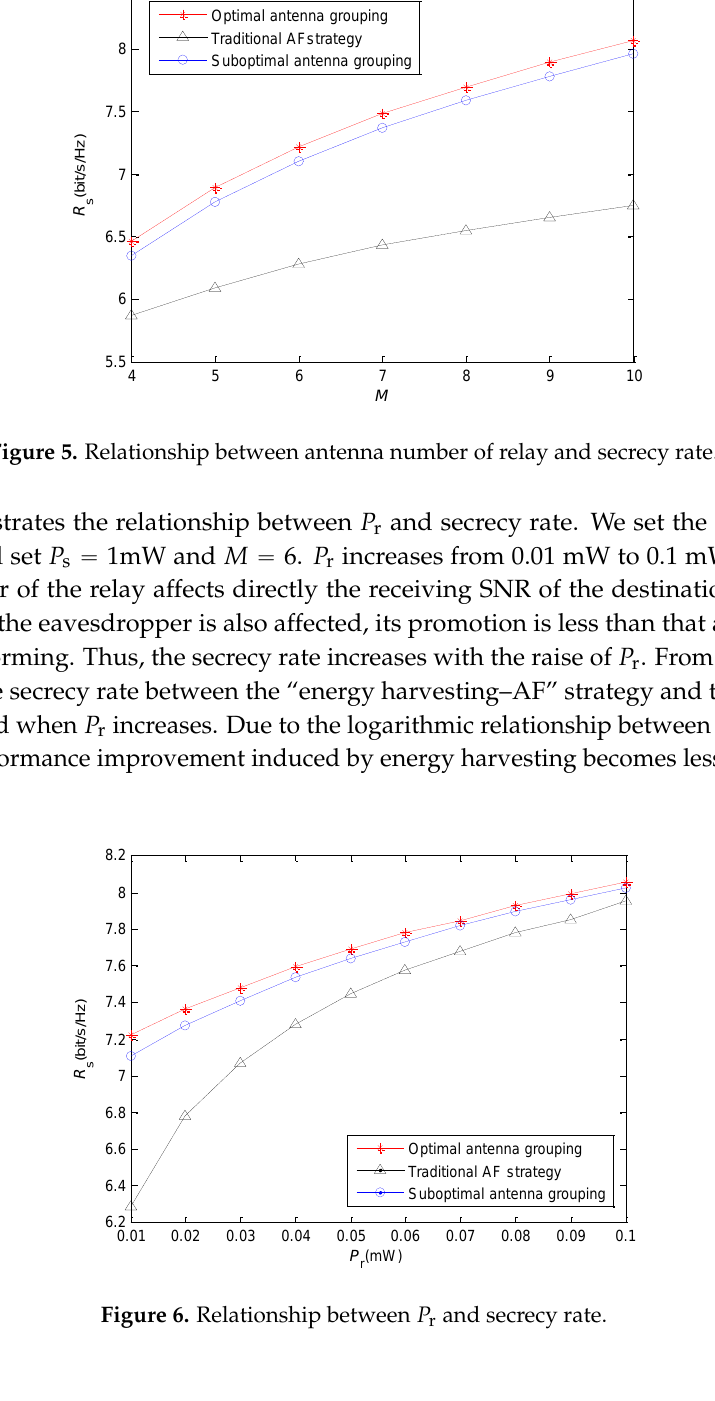
Figure 6. Relationship between